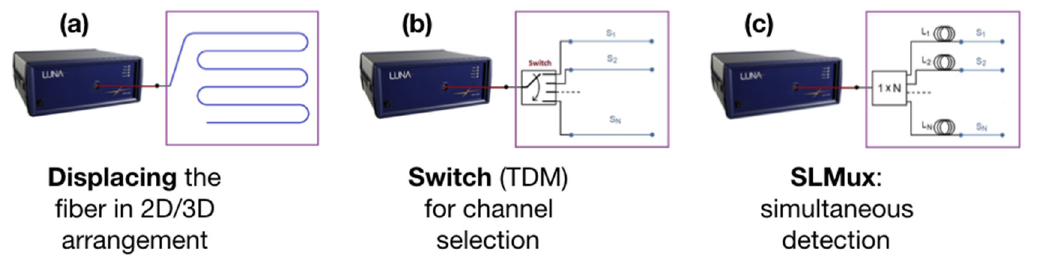
Figure 1. Schematic of the optical backscatter reflectometry (OBR) setup for the measurement of planar (2D) or tridimensional (3D) arrangements. ( a ) The fiber is displaced in a 2D / 3D configuration, as in [15]; this is impractical for several medical devices, due to limited spacing, tight bending and excessive mechanical torsions of the fiber. ( b ) The alternative is to use a 1 × N switch (TDM arrangement), to single out each individual channel [17,22]; in this arrangement, the OBR loses a large portion of real-time sensing, due to the significant increase of measurement time (N-fold increase, with ideal switches and optimal software), well over 1 s. ( c ) The SLMux setup [18,19], presented in this work; the switch is substituted by a splitter, hence the detection is simultaneous and real-time (0.3 s). A network of single-mode fiber delayers and high-scattering fiber multiplex from a single fiber to the N-size sensing network, each constituted by a distributed sensor.